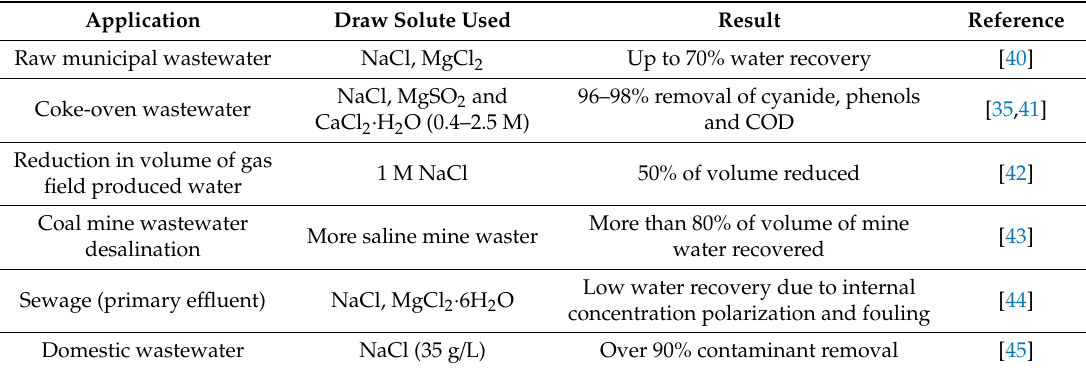
Table 3. Applications of FO in wastewater